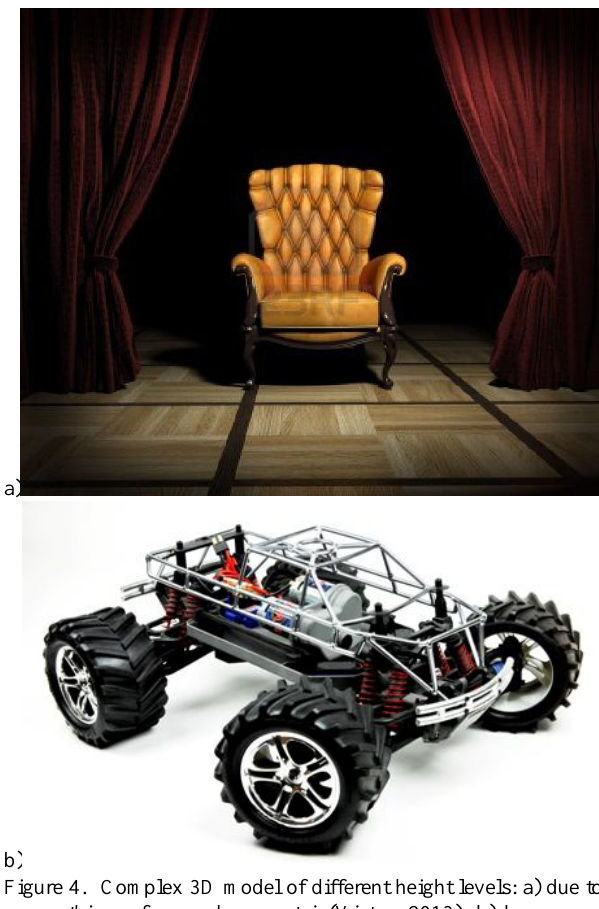
Figure 4. Complex 3D model of different height levels: a) due to a thin surface such as curtain(Victor, 2013). b) because of thin bars that form the body of main object(“Monster GT